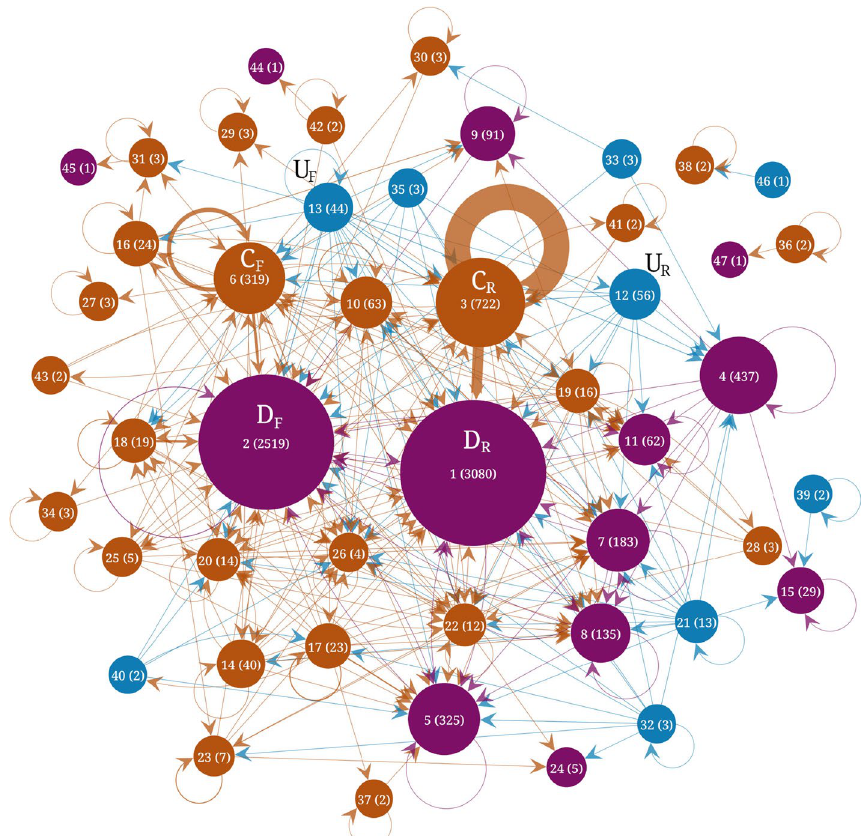
Fig. 4 Flow stability clustering of the telegram channels network G 1 (Sep. 2015 to June 2019). Nodes represent the communities and edges represent the number of links between channels in each community. Upstream communities are shown in blue, core communities in brown and downstream communities in purple. The labels indicate the rank of each community in terms of size and the size is indicated in